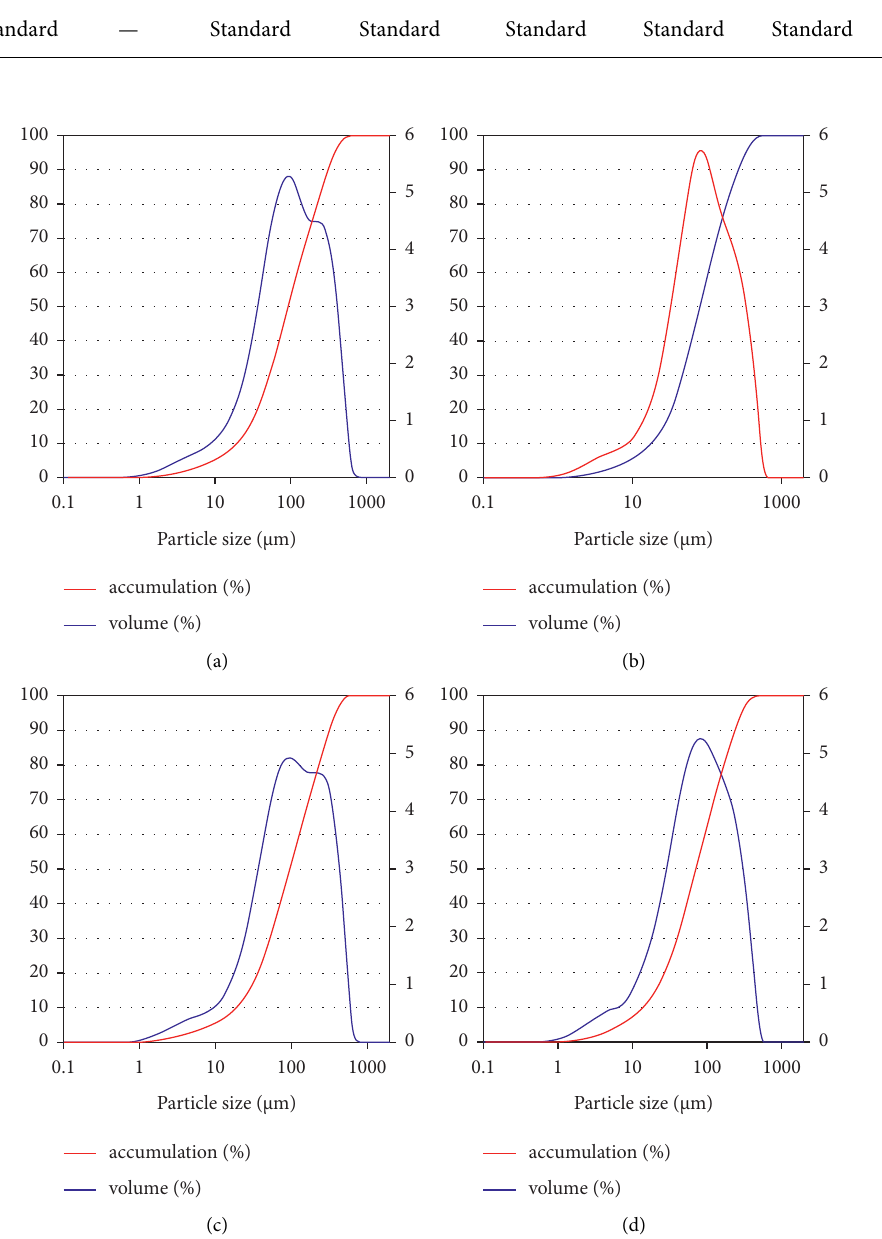
Figure 1: Particle size distributions of marble powder under different grinding time: (a) particle distribution grinding for 1 minute; (b) particle distribution grinding for 5 minutes; (c) particle distribution grinding for 30 minutes; (d) particle distribution grinding for 120 minutes.